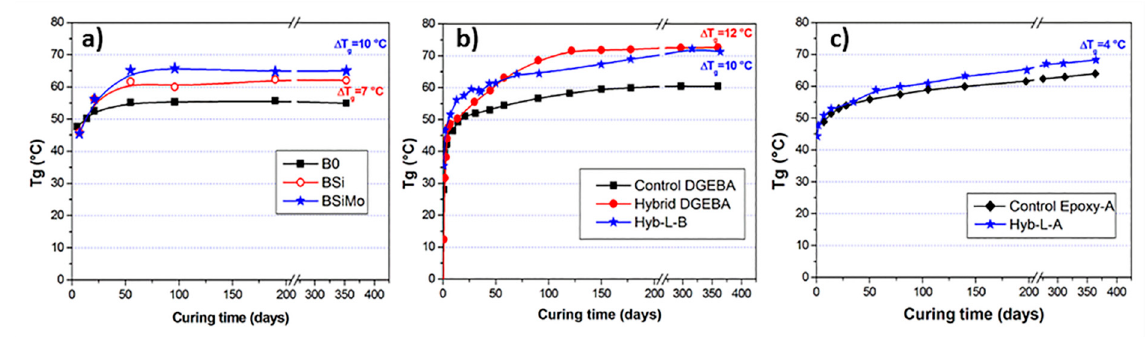
Figure 1. Glass transition temperature ( T g ) values at different cold-curing times for hybrid and control epoxy systems: ( a ) B0, BSi, BSiMo; ( b ) Control bis-phenol A (DGEBA), Hybrid DGEBA, Hyb-L-B samples; ( c ) Control Epoxy A, Hyb-L-A samples.